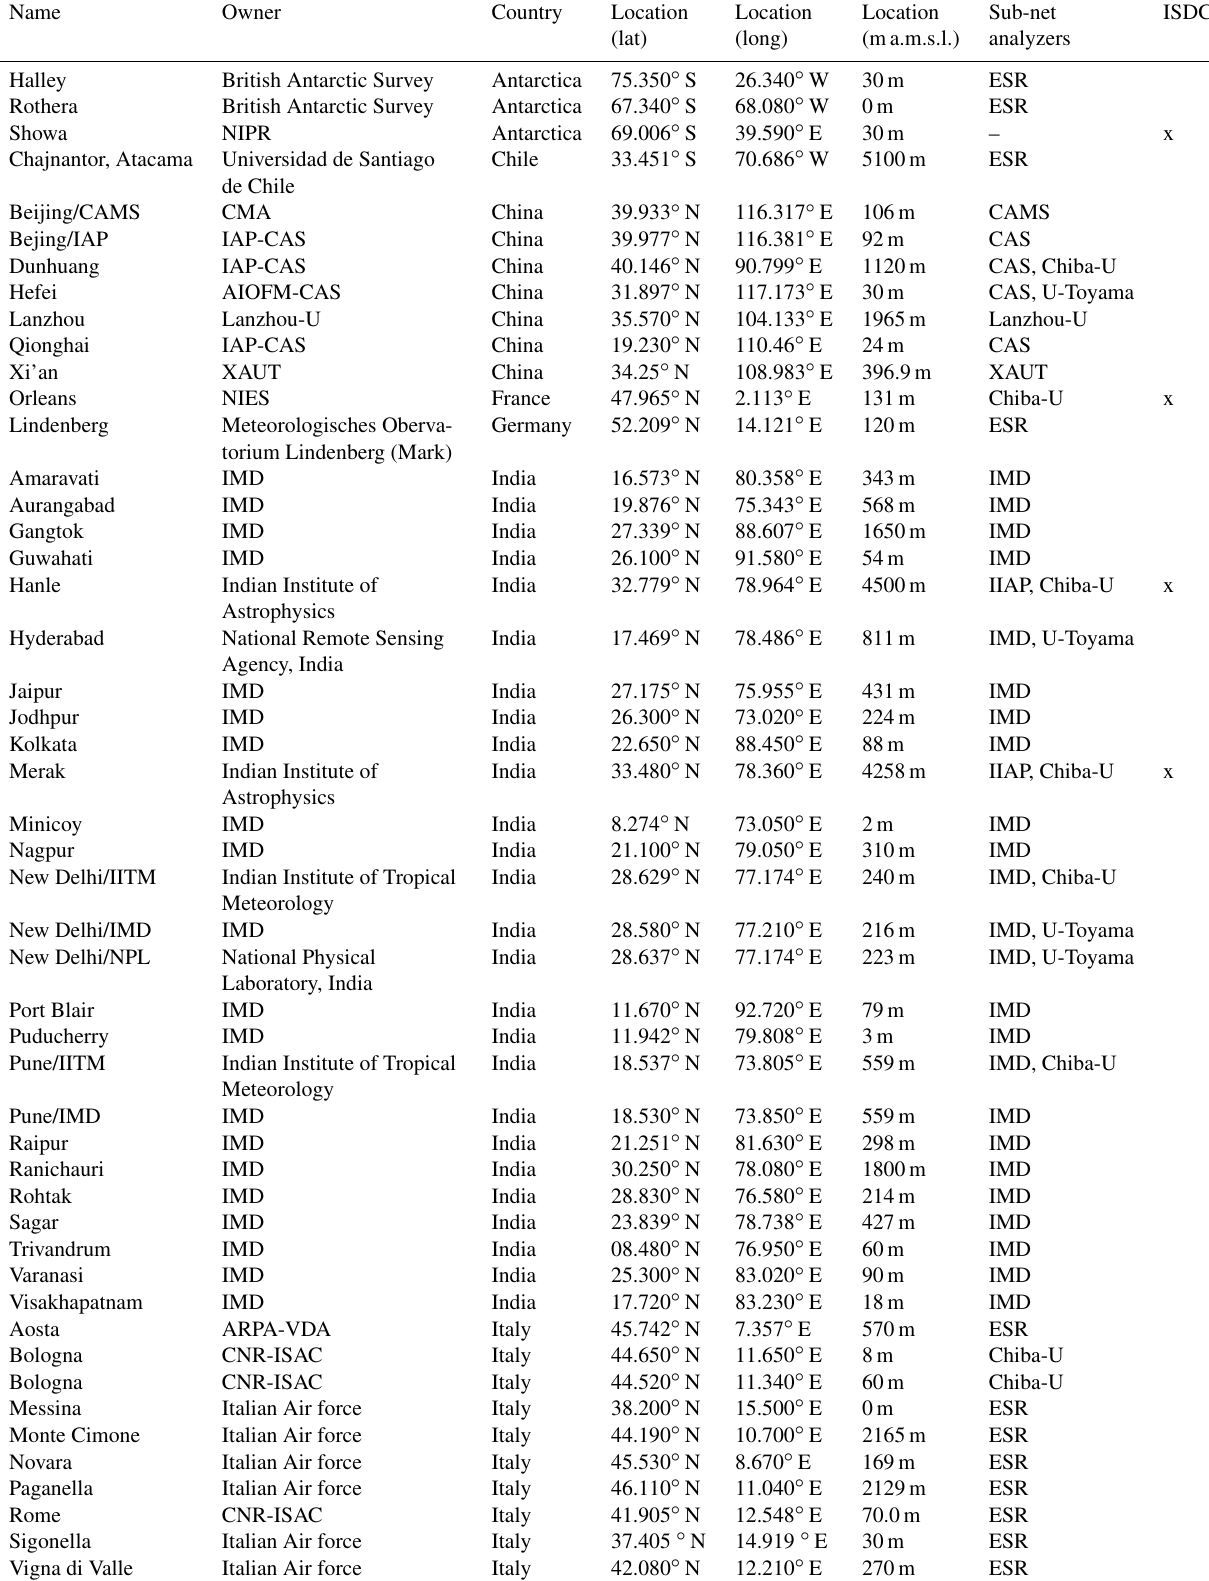
Table 1. Sites recognized by the International SKYNET